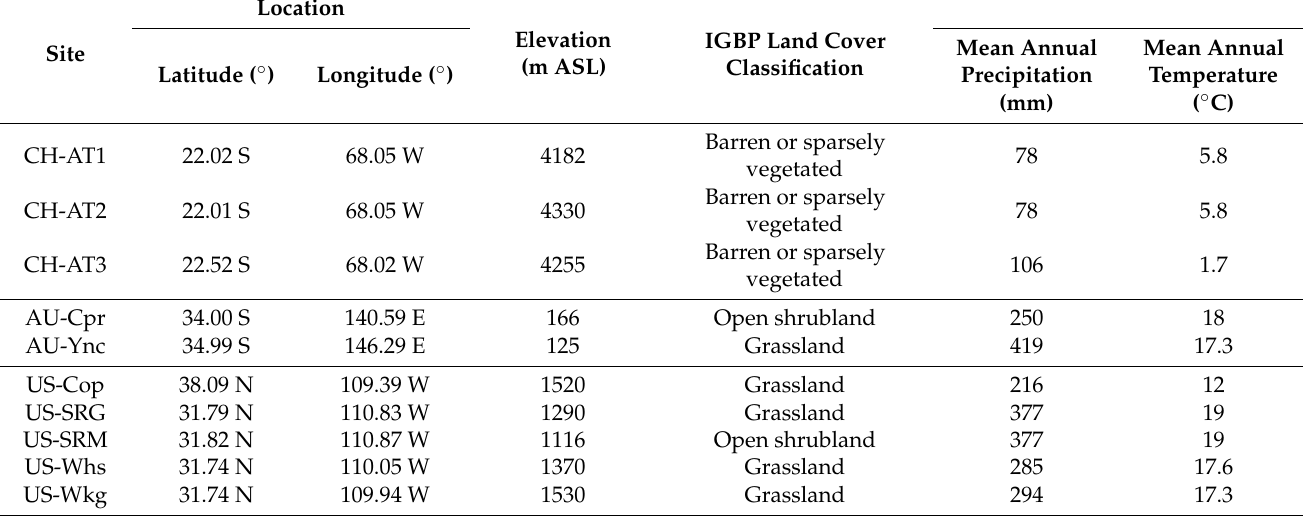
Table 1. Site name, location (latitude and longitude), elevation, International Geosphere-Biosphere Programme (IGBP) land cover classification, and mean annual precipitation and temperature of the study sites. The country of each site is coded as follows: Chile (CH), Australia (AU), and the United States